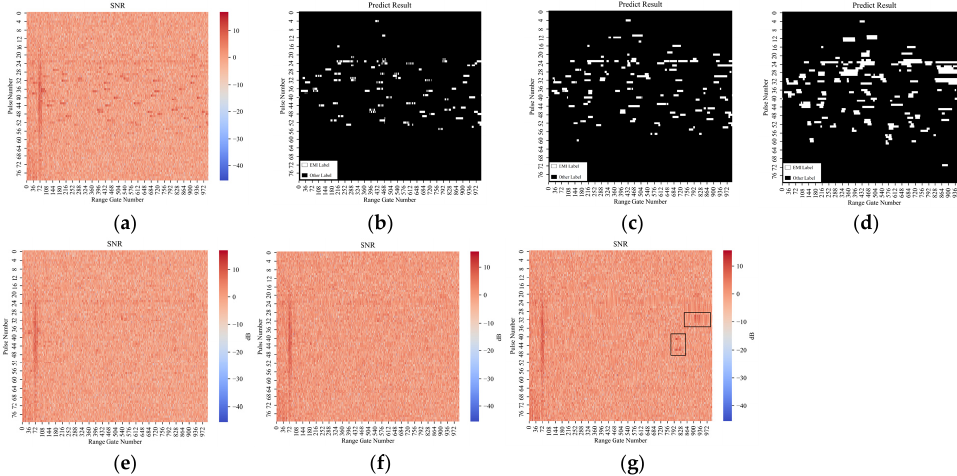
Figure 6. Identification and suppression results of the problems among the three models. ( a ) Raw data; ( b ) semantic segmentation results of UNet; ( c ) semantic segmentation results of ResNet with UNet structure; ( d ) semantic segmentation results of DeepLab V3+; ( e ) EMI suppression results after UNet semantic segmentation; ( f ) EMI suppression results after ResNet semantic segmentation; ( g ) EMI suppression results after DeepLab V3+semantic segmentation.